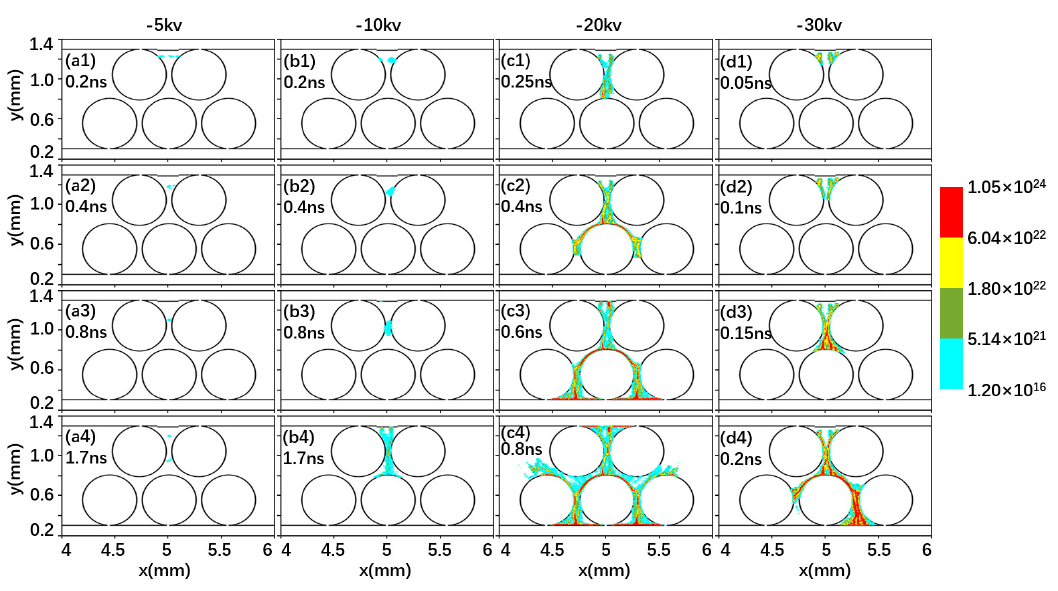
Figure 1. Electron density (m − 3 ) at different times, for different driving voltages, i.e., − 5 kV ( a1 – a4 ), − 10 kV ( b1 – b4 ), − 20 kV ( c1 – c4 ), and − 30 kV ( d1 – d4 ), in an air discharge. The same color scale is